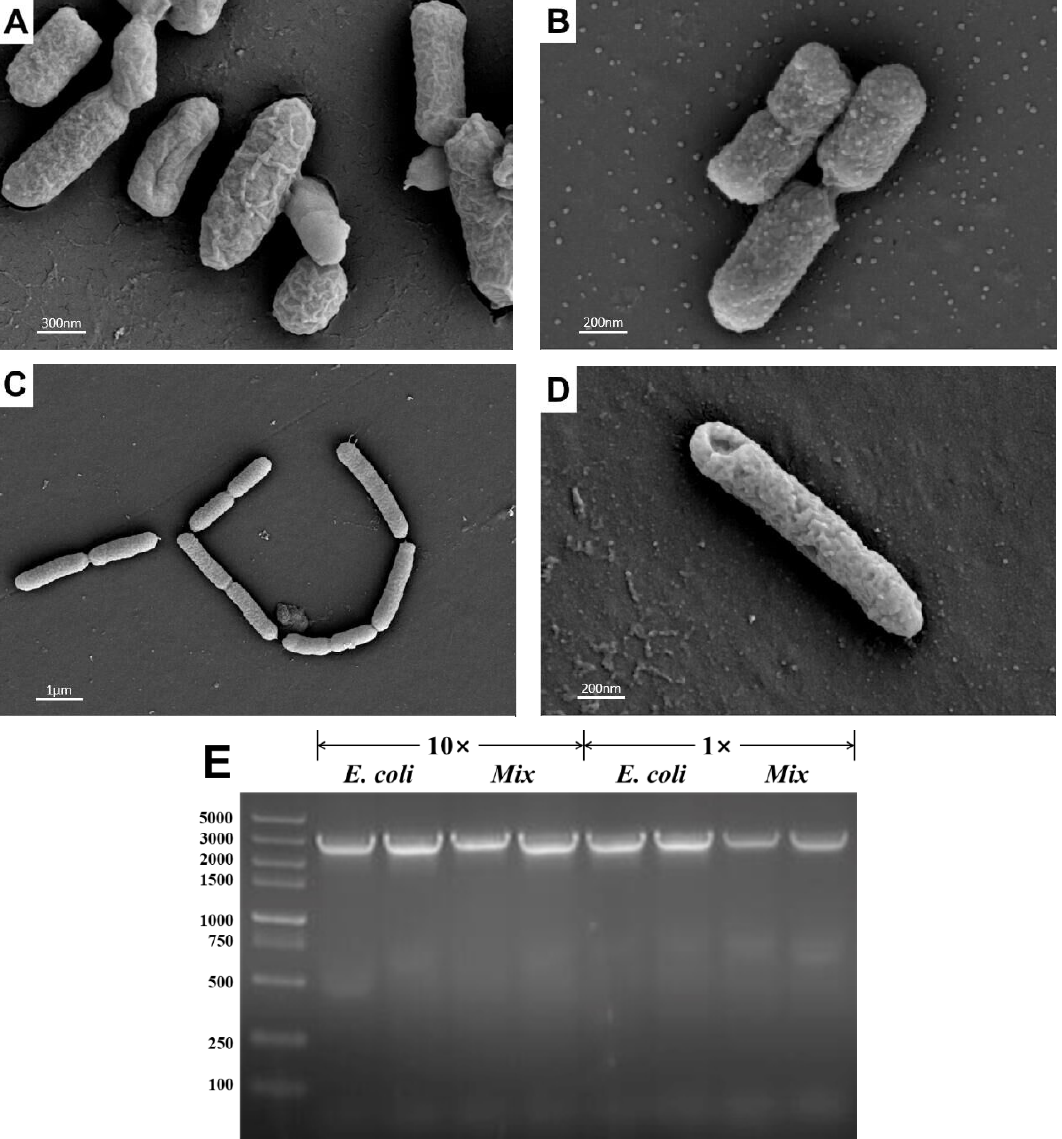
Figure 6. Evaluation of the targeting effect of PLGA-TNPs loaded with MC and CAPE on R. solanacearum . Normal electron micrographs of E. coli ( A ) and R. solanacearum ( C ) are presented. The PLGA-TNP treatment groups of E. coli and R. solanacearum are presented in ( B ) and ( D ). Bacterial universal primers were employed to perform PCR detection on a bacterial solution of E. coli and R. solanacearum and generate a gel image ( E